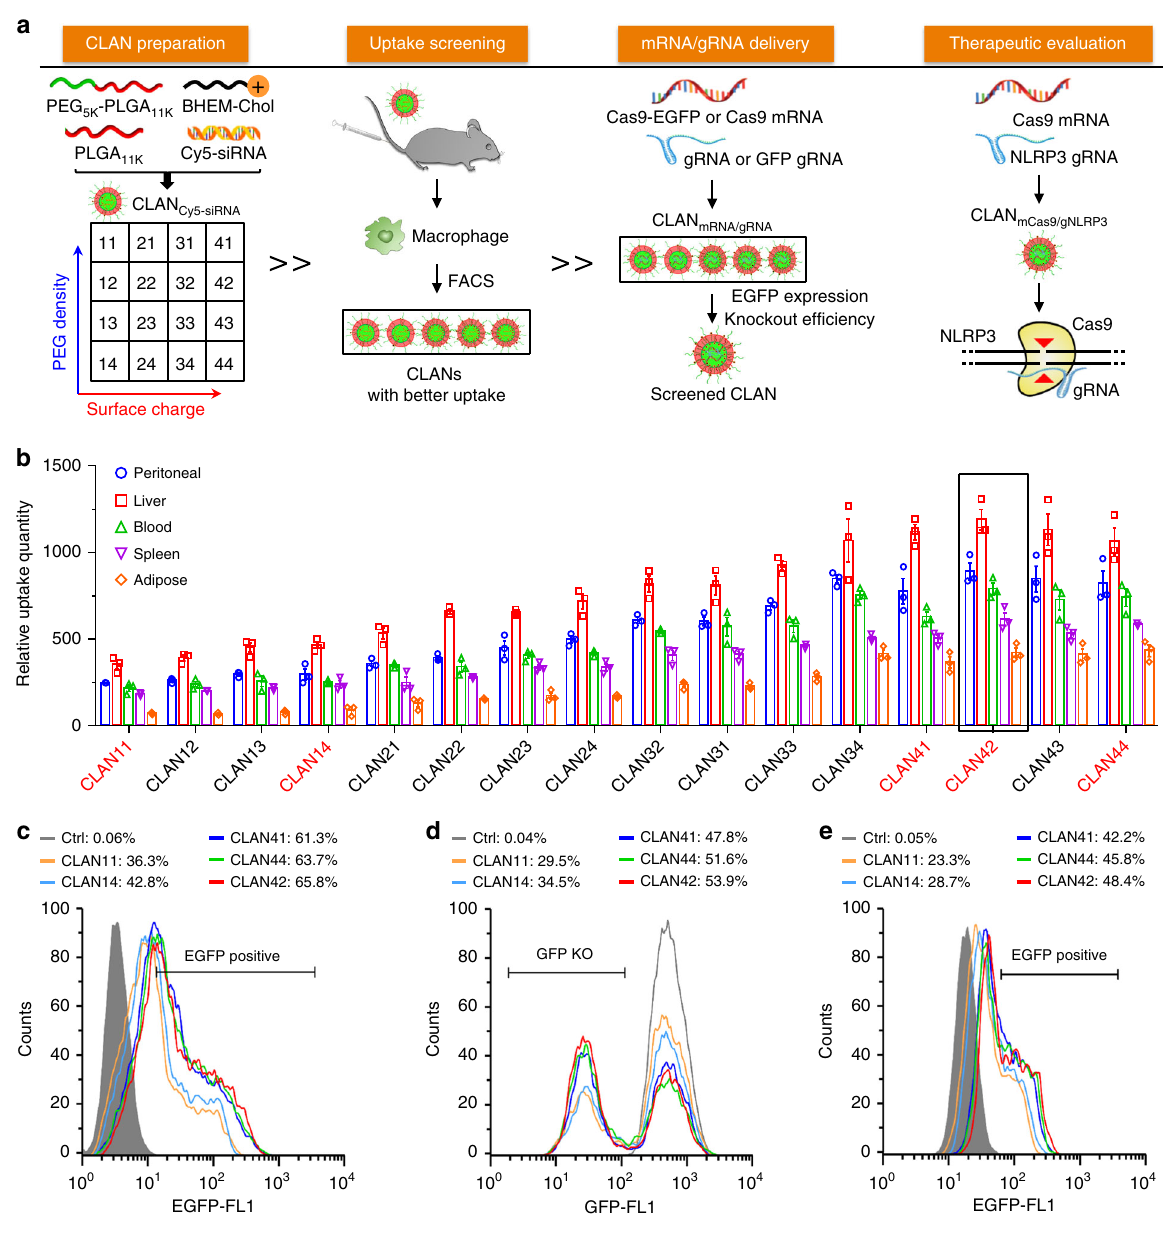
Fig. 1 Screening of CLAN for mCas9/gRNA delivery to macrophages. a General scheme of this study. We fi rst prepared a CLAN library of different surface charge or PEG density by adjusting the amount of BHEM-Chol or polymers (PEG 5K - b -PLGA 11K and PLGA 11K ). Next, we evaluated macrophage uptake of CLAN Cy5-siRNA by FACS. Screened CLANs were used to encapsulate Cas9-EGFP or Cas9 mRNA and gRNA. EGFP expression of CLAN mCas9-EGFP/gNC and the GFP-knockout ef fi ciency of CLAN mCas9/gGFP were detected to determine which CLAN was better for macrophage gene editing. Finally, we encapsulated mCas9/gNLRP3 into screened CLAN to prepare CLAN mCas9/gNLRP3 and used it for in fl ammatory disease treatment. b FACS analysis of the relative uptake quantity of each CLAN Cy5-siRNA in macrophages of mice injected with different CLAN Cy5-siRNA . c FACS analysis of EGFP expression in BMDMs transfected with each CLAN mCas9-EGFP/gNC . d FACS analysis of the GFP knockout ef fi ciency of Raw264.7-GFP cells transfected with each CLAN mCas9/gGFP . e FACS analysis of EGFP expression in peritoneal macrophages of mice injected with each CLAN mCas9-EGFP/gNC . The data are shown as the means ± SEM of n = 3 ( b ) or are representative of three independent experiments ( c – e